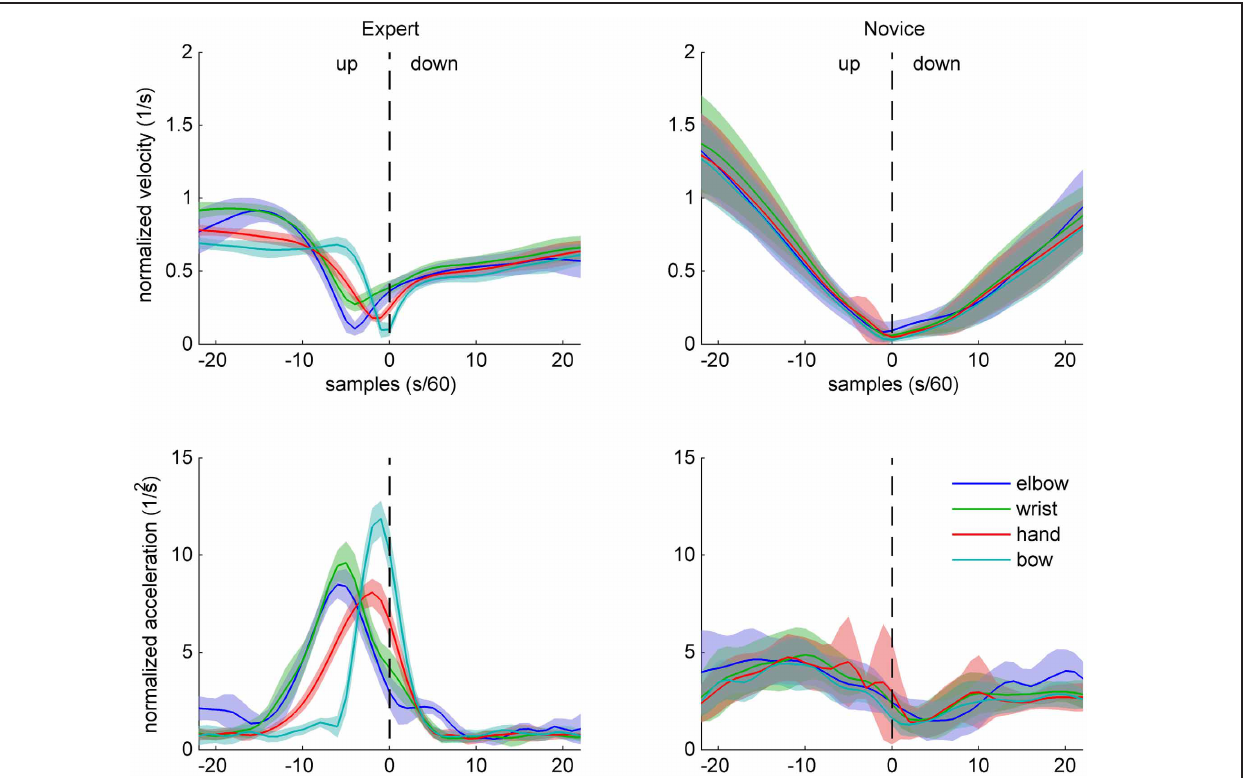
FIGURE 4 | Sample data of arm and bow kinematics (velocity and acceleration, normalized relative to the shoulder joint) for an expert (left) and a novice (right) cello player, during an up-down bow reversal. Shaded areas indicate SD across movements.